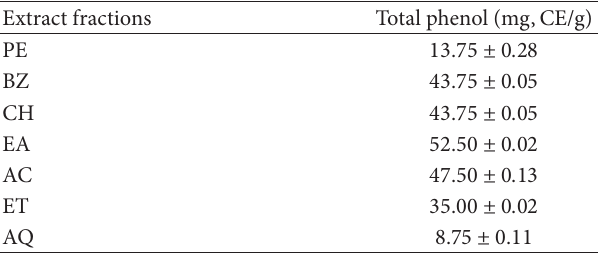
Table 2: Contents of total phenol in T. cordifolia stem extracts. Extract fractions